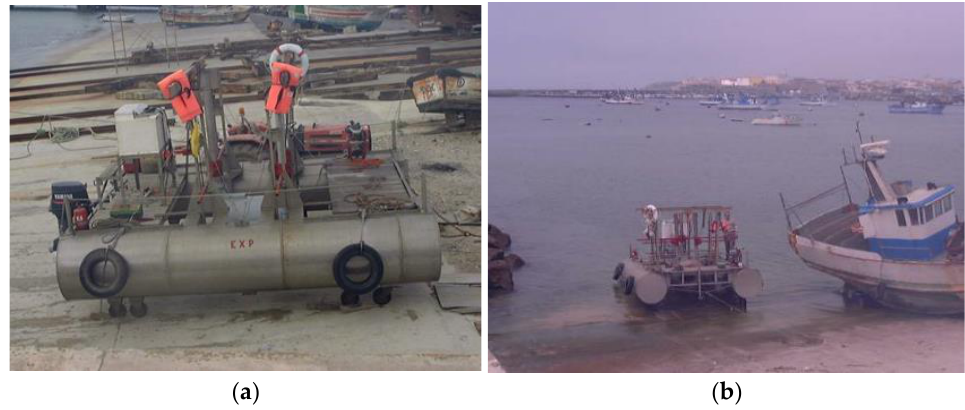
Figure 4. ( a ) Lateral view of the platform with the raft and the duct scale model D2 at the naval dockyard ramp and ( b ) image of the platform entering water or arriving at the dockyard ramp. Figure 5a,b show duct scale models D2 and D4 at the higher level partially immersed in the water when the platform was tied to the quayside. Figure 6a,b show duct scale models D2 and D4 at the lower level immersed in water with the highest part about 0.5 m below the water surface when the platform was tied to the quayside. Figure 7a,b show when duct scale models D3 and D4 were fixed at the lower level with the highest part at about 0.5 m below the water surface.